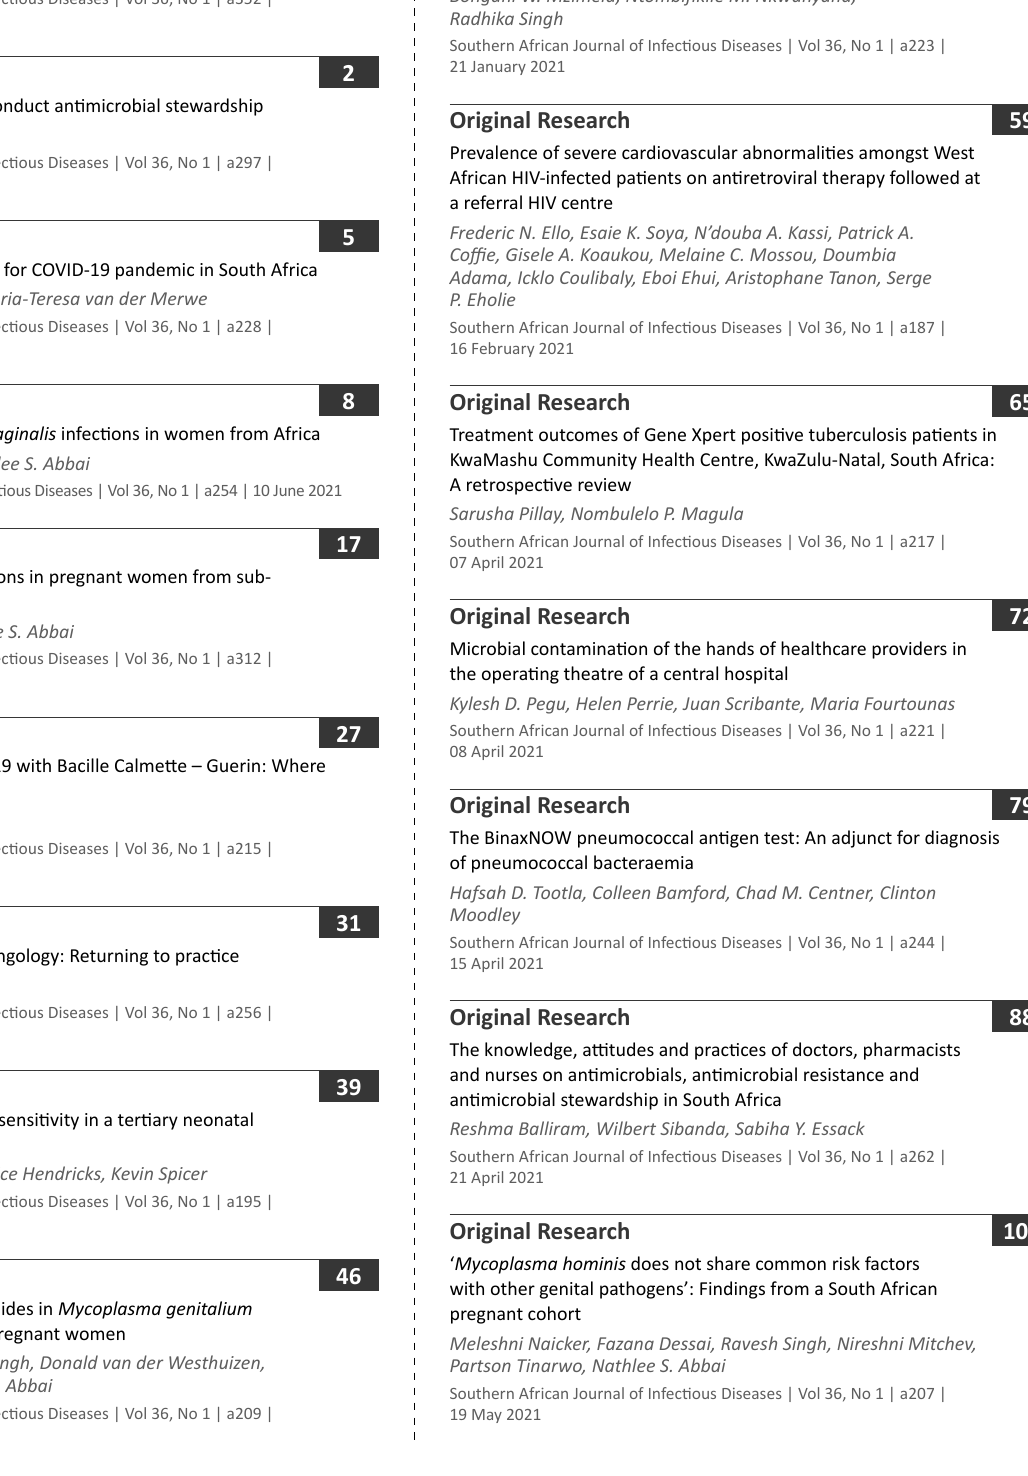
Where are we in